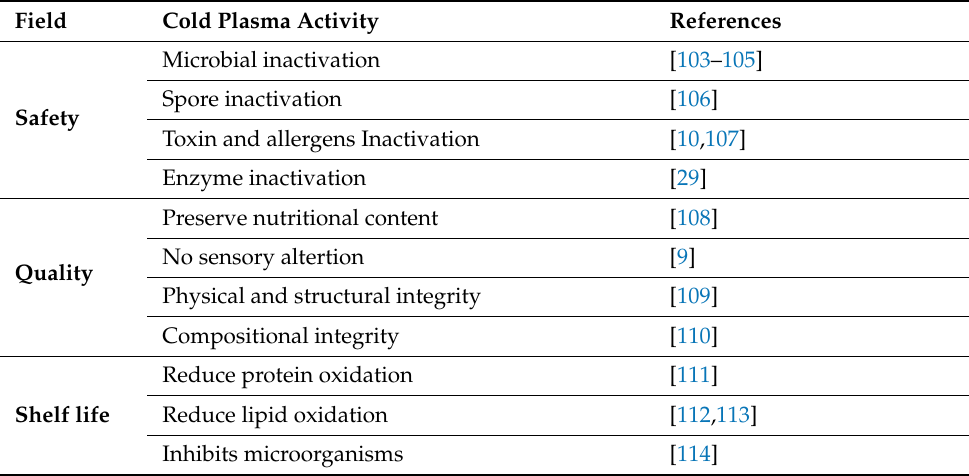
Table 5. Advantages of cold plasma in food